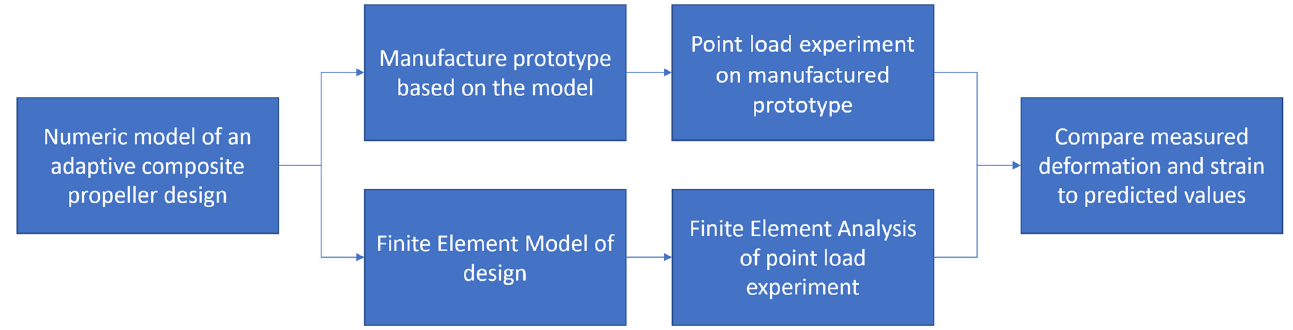
Figure 1. Block diagram to visualise the structure of the research in this